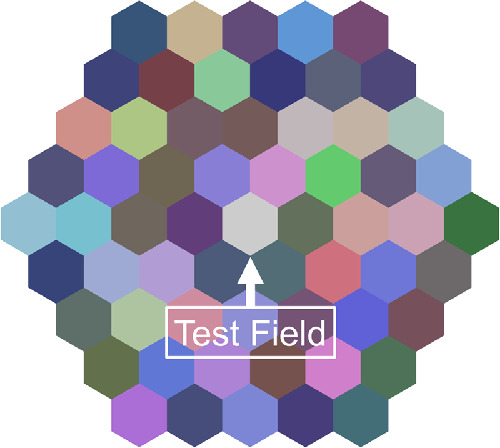
An example of an experimental stimulus configuration that consists of 61 uniformly colored hexagons—the center test field and 60 surrounding stimuli (30 bright colors and 30 dark colors). Each hexagon is subtended 2° diagonally. The chromaticity and luminance of the test field were adjusted by observers. This example is a mountain distribution under 6500 K in Experiment 1. The spatial pattern was shuffled for each trial.